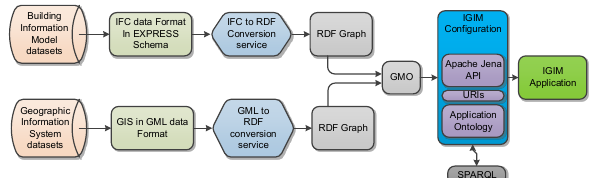
Figure 7. IGIM system architecture and data translation flow